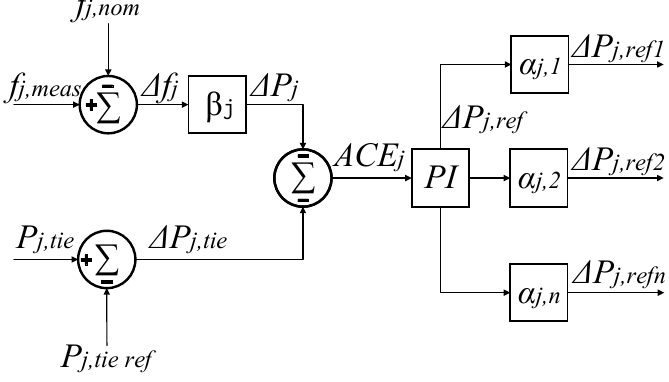
Figure 6. Secondary frequency control (AGC) scheme.